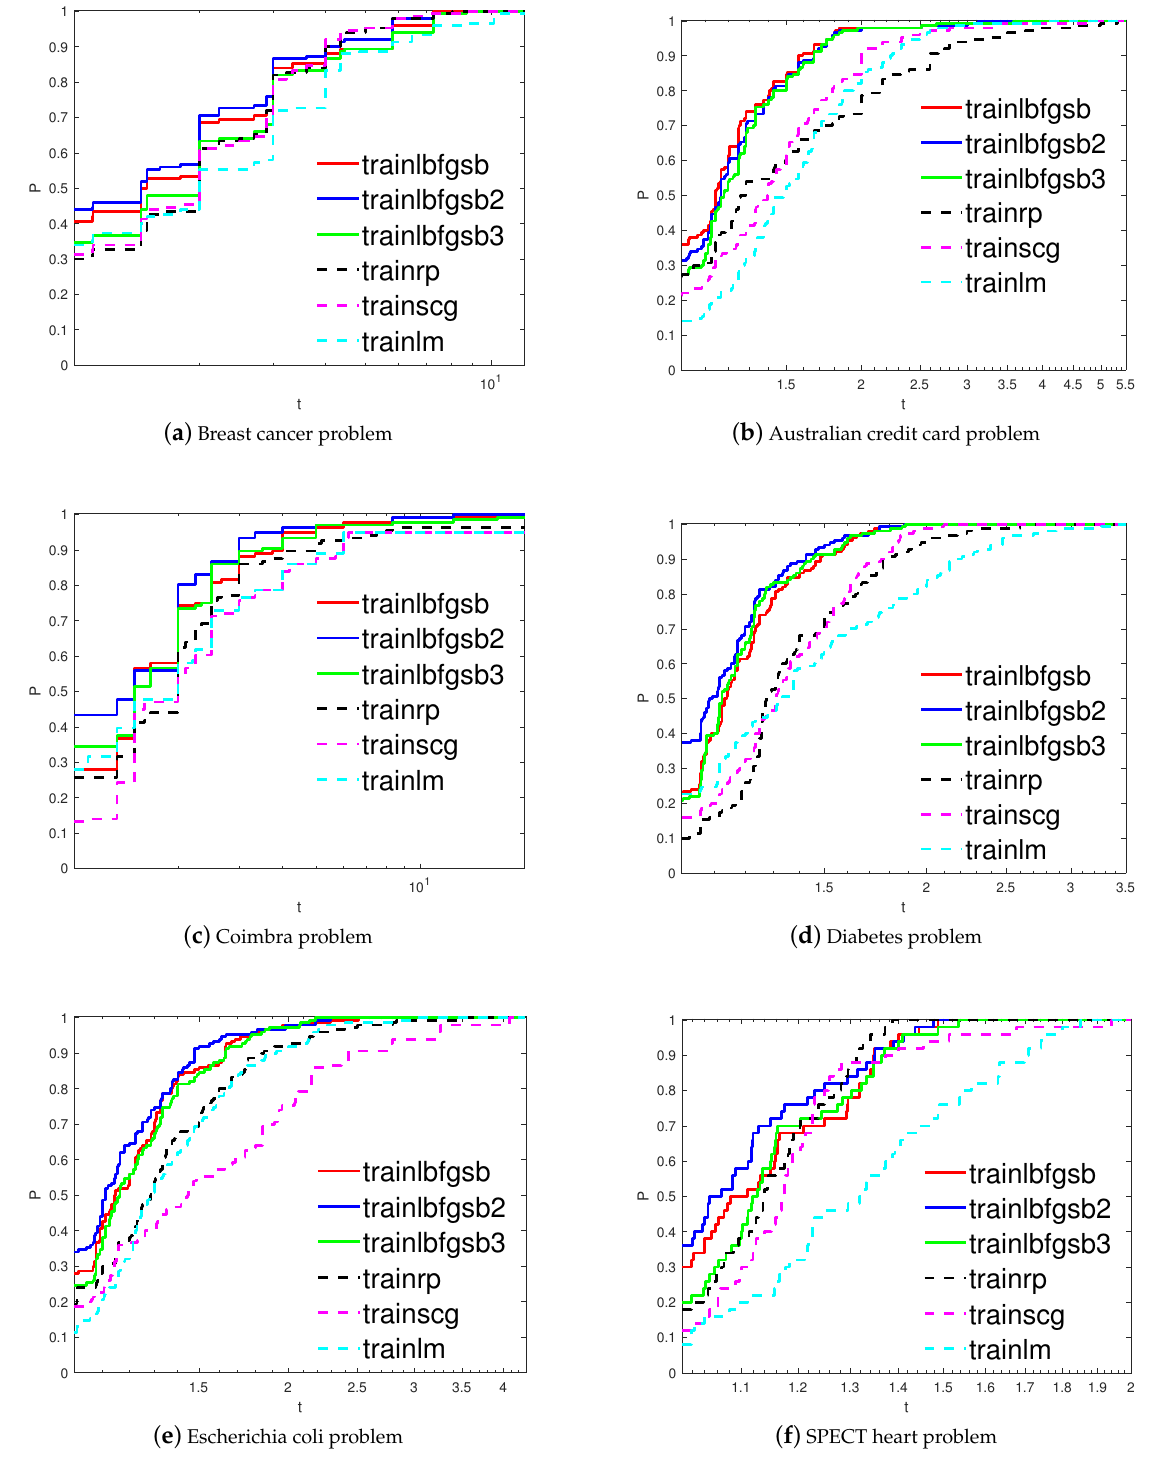
Figure 13. Log 10 scaled performance profiles based on accuracy of WCNN against the state-of-the-art training algorithms R PROP , SCG and